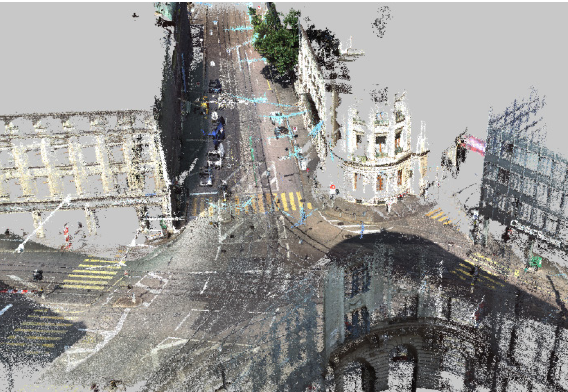
Figure 10. Filtered and fused point cloud exploiting five match images per base image (configuration 4)